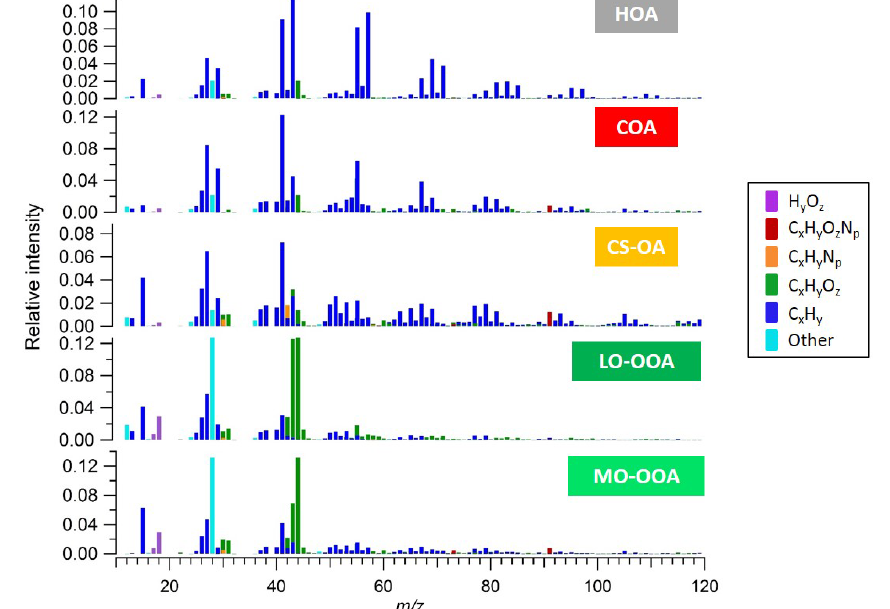
Figure 1. Mass spectra of the five identified OA factors, colour-coded by chemical